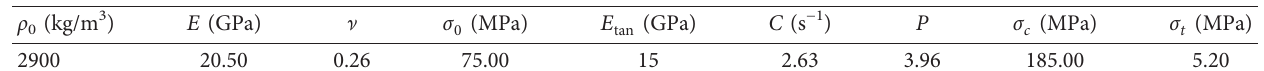
Table 3: Parameters of rock in simulation.